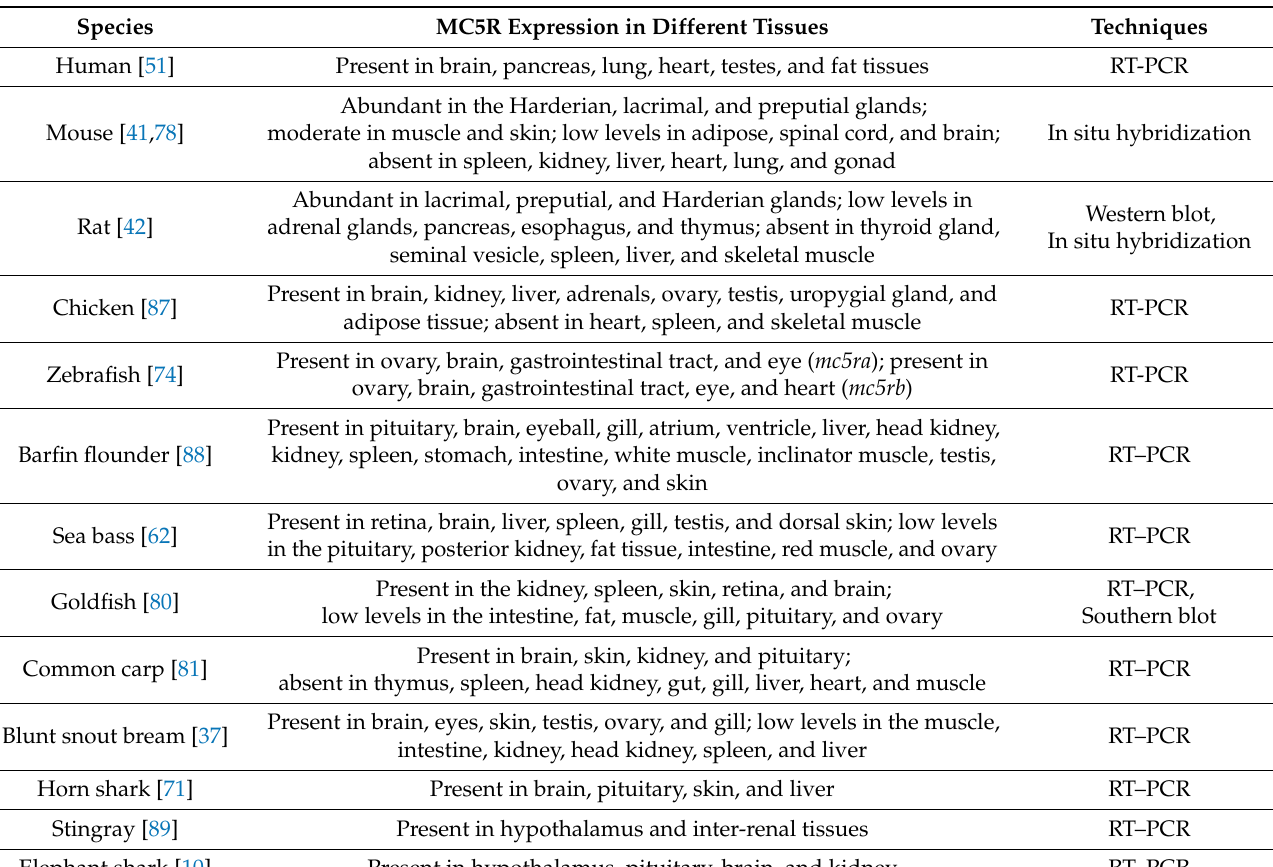
Figure 4. Comparative synteny analysis of MC5R . Chromosomal location and adjacent genes of MC5R are shown in different species. Genes with conserved synteny between at least two species are shown in the boxes with the same color (except the white box). Table 1. The distribution of MC5R in different species.